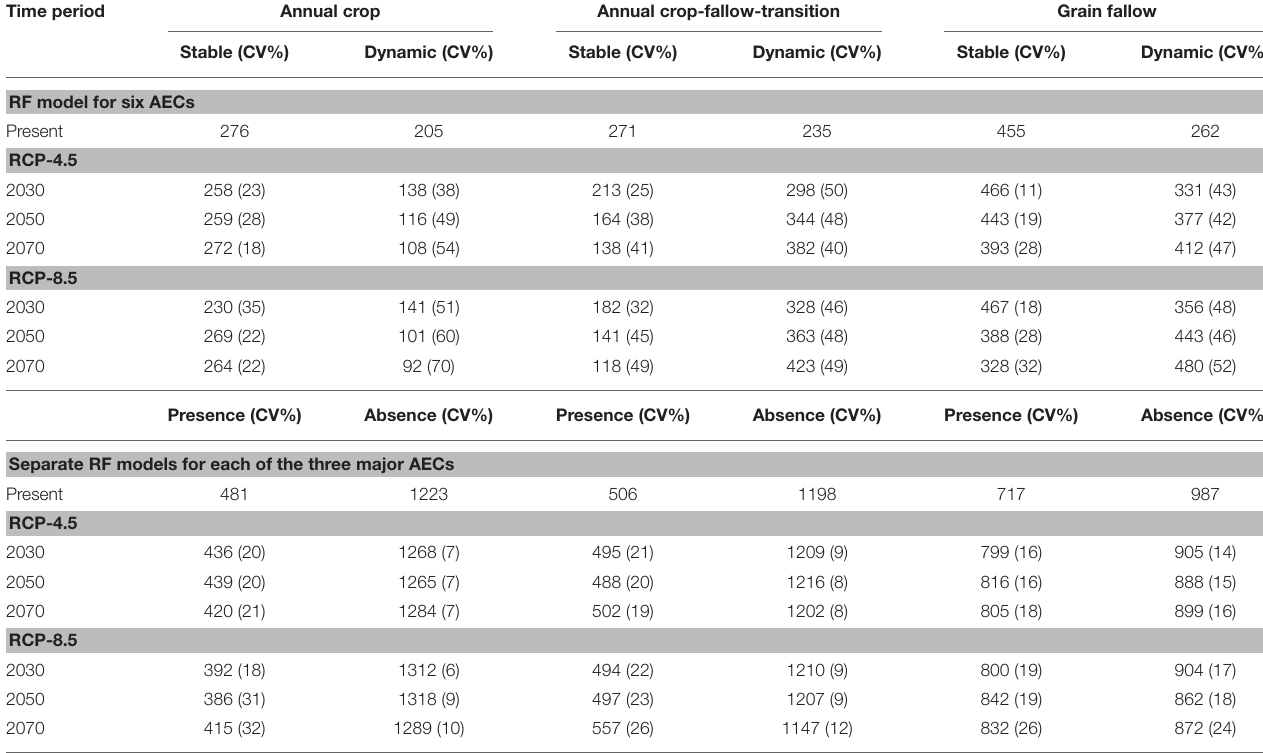
TABLE 5 | Agro-ecological class (AEC) (number of 4 × 4 km pixels) for present time period and predicted number, average and coefficient of variation (CV%), under three future time periods and two representative concentration pathway (RCP-4.5 and 8.5) scenarios derived from 17 global climate models using Random Forest (RF) models for six and three